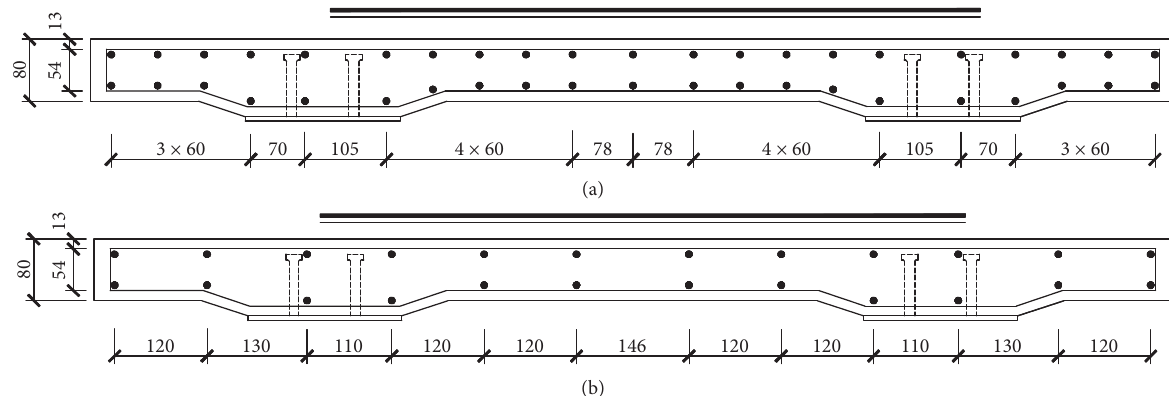
Figure 6: Structure of ordinary reinforcement in concrete slabs (unit: mm). (a) PLG-1: reinforcement ratio 1.72%. (b) PLG-2: reinforcement ratio